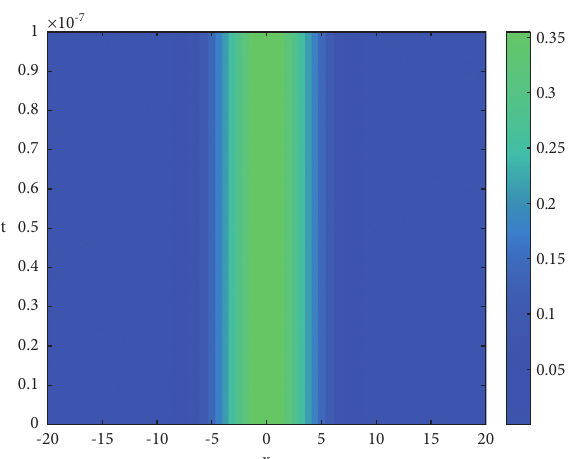
Figure 3: Contour of fractional temporal numerical solution u ( x ) for order α � 0 . 6, κ � 4, and δ � 5.